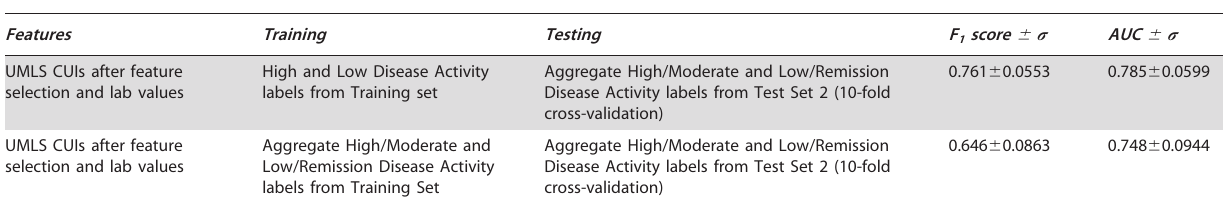
Table 4. Portability